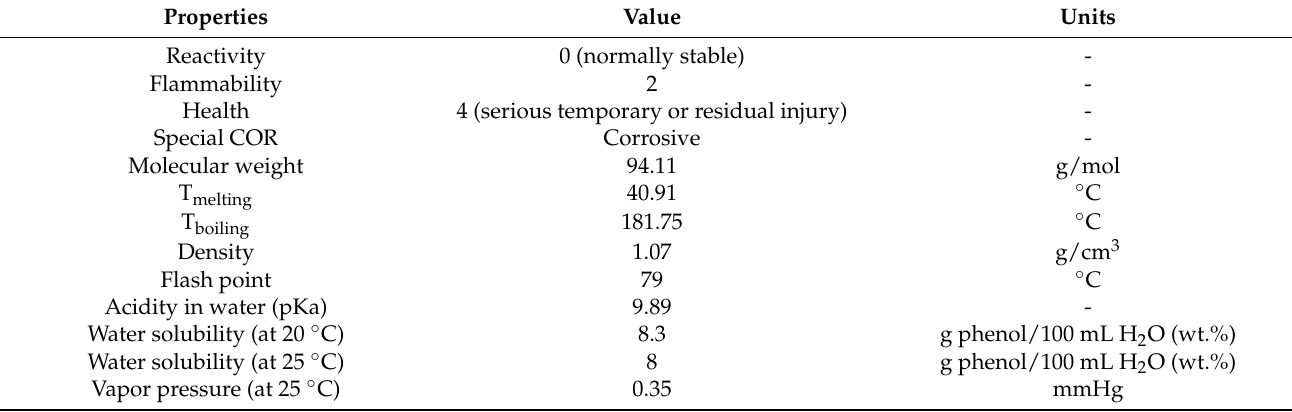
sity of the aromatic ring that affects the solubility of phenol compounds in water [13]. The physiochemical properties of phenol are shown in Table 2. Table 2. Chemical and physical properties of phenol. Adapted from ref. [14]. Copyright 2015 Taylor & Francis Online.